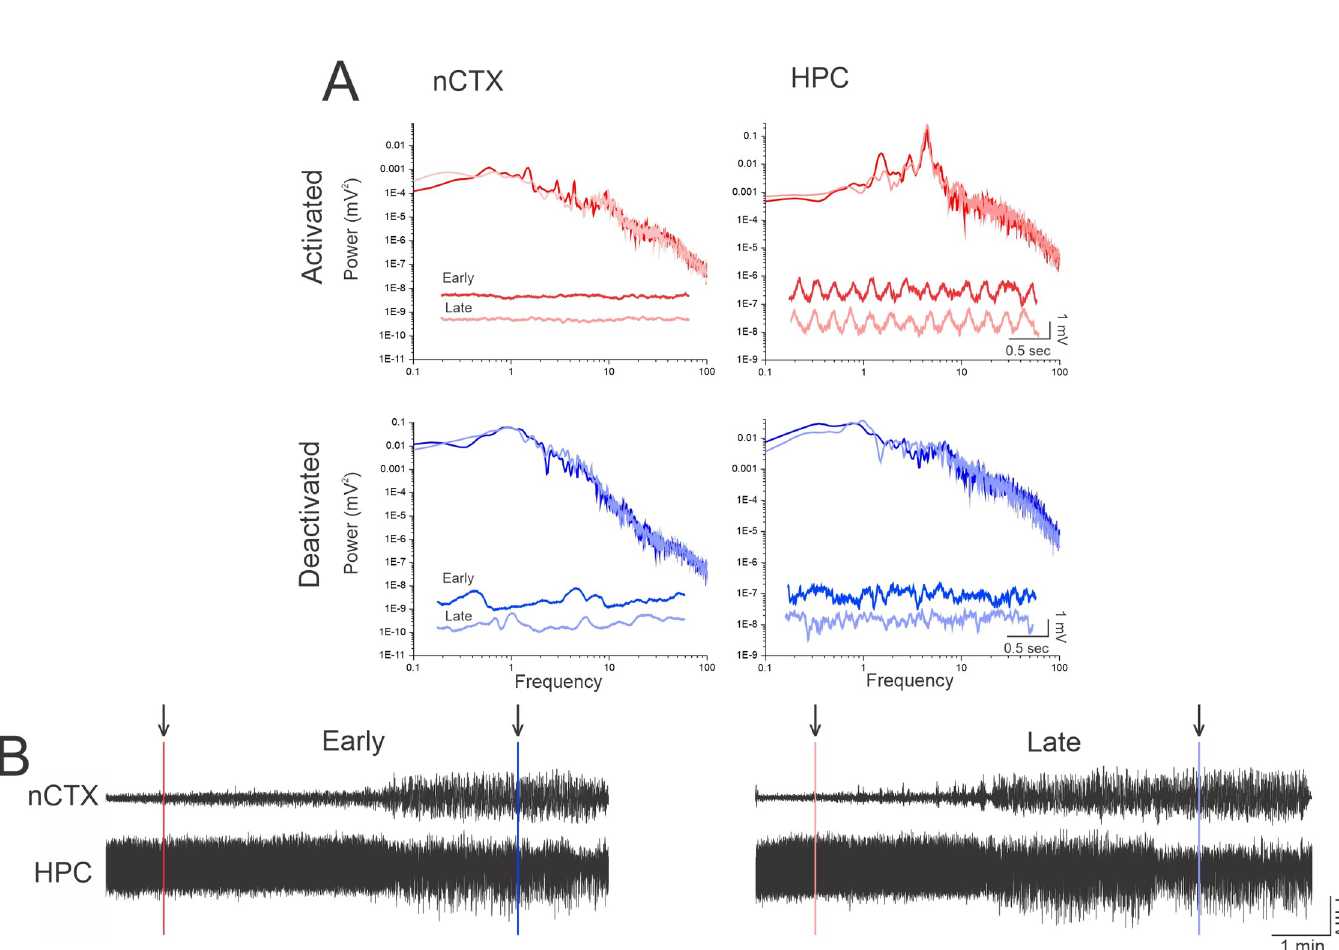
Fig 2. Spontaneous cyclic alternations of brain state under urethane anesthesia. A) Power analysis of the nCTX shows low voltage, higher frequency activity in the activated state both early (36 minutes) into the recording (dark red) and late (184 minutes) into the recording (light red). The HPC shows a strong peak corresponding to theta activity associated in the activated state both early (dark red) and late (light red) in the recording. Power analysis of the nCTX in deactivated shows a high voltage low frequency activity, associated with slow oscillations both early (43 minutes) into the recording and (dark blue) and late (190 minutes) into the recording (light blue) in the recording. The HPC shows high voltage, low frequency activity in the deactivated both early (dark blue) and late (light blue) in the recording. No major changes in power analysis is noted across states in both the nCTX and HPC in comparison of early and late recordings. Three second traces from the nCTX and HPC in both activated (red) and deactivated (blue) states are inserted in the corresponding power analysis. Early activated (36 minutes) in dark red and deactivated (43 minutes) in dark blue are the top traces. Late activated (184 minutes) in light red and deactivated (190 minutes) in light blue are the bottom traces. B) 9.5 minute trace of the nCTX (top) and HPC (bottom) early highlighting one cycle both (starting at 35 minutes into the recording) and a 10.5 minute trace of the nCTX (top) and HPC (bottom) late highlighting one cycle (starting 181 minutes into the recording). Lines and arrows indicate the location of the three second excerpts and where power analysis was taken for each state.